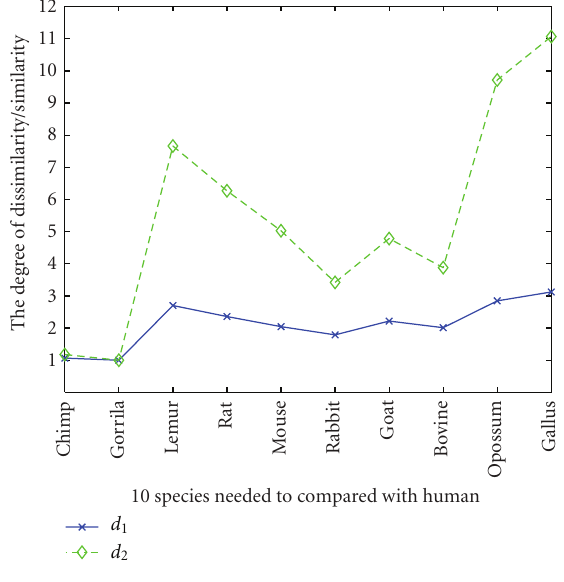
Figure 1: The degree of dissimilarity/similarity of the other 10 species with human, where the degree of dissimilarity/similarity of the pair human-gorilla is defined relatively as 1.